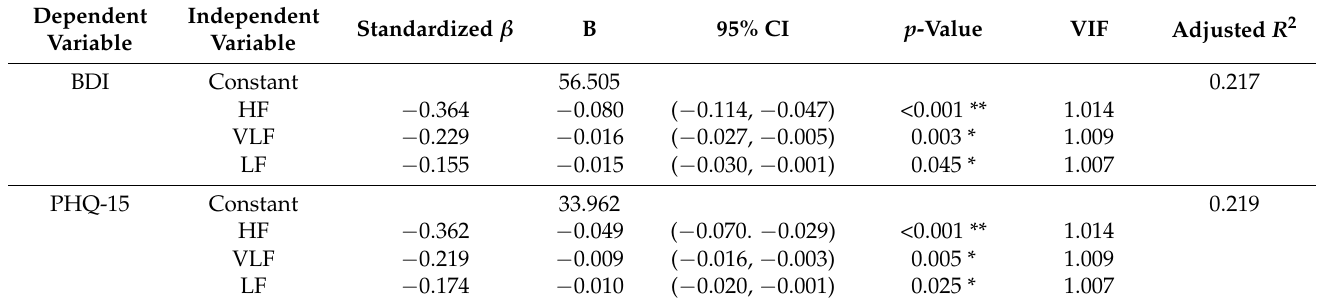
Table 7. Multiple linear regression analysis HRV parameters as an associated factor of depression and somatic symptom